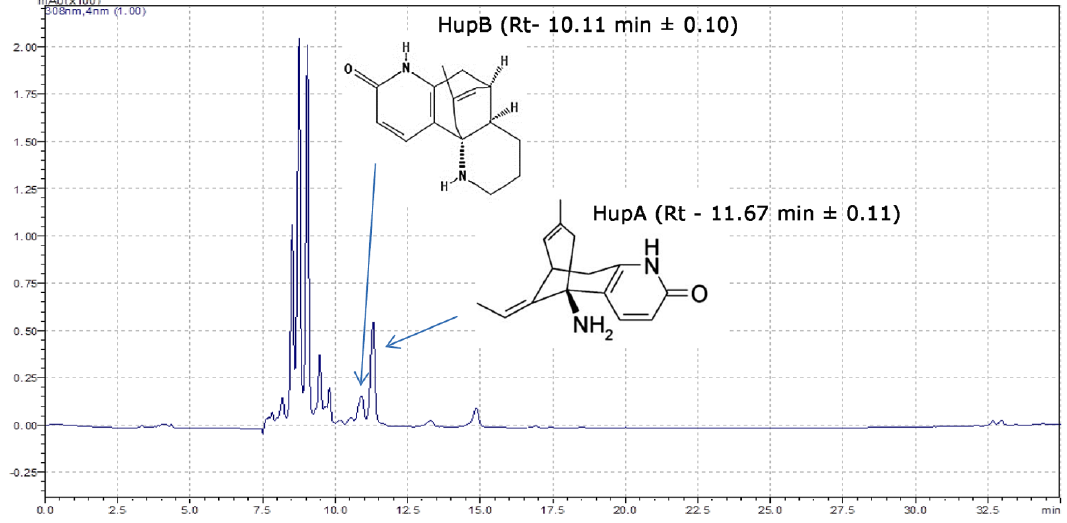
Figure 6. Sample chromatogram of H. selago extract (gametophytes from culture). Table 1. Huperzia selago gametophyte alkaloids identified by high resolution mass spectrometry and Formula Predictor